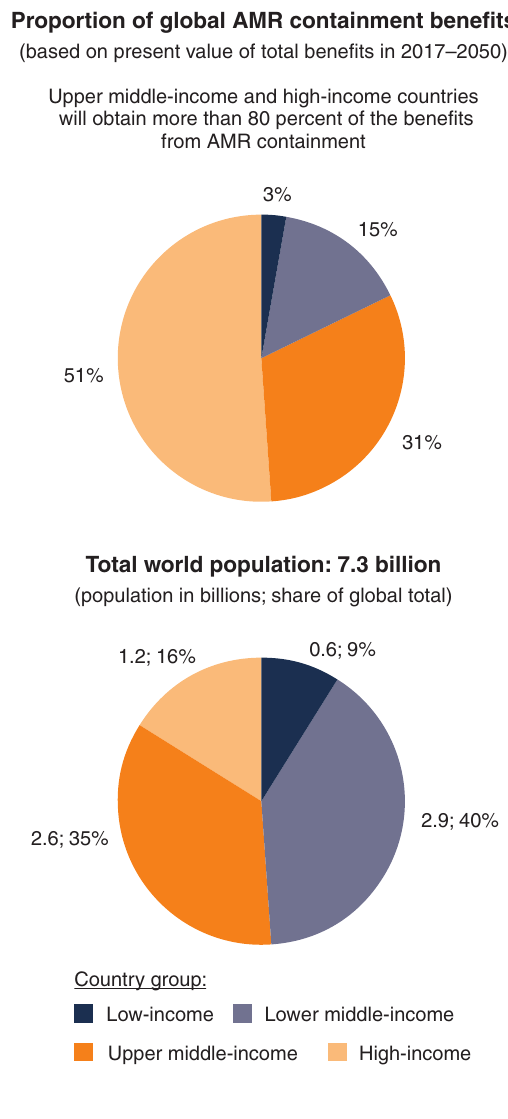
FIGURE 11. High-Income and Upper Middle-Income Economies Stand to Benefit the Most from AMR Containment, Both in Absolute and per Capita